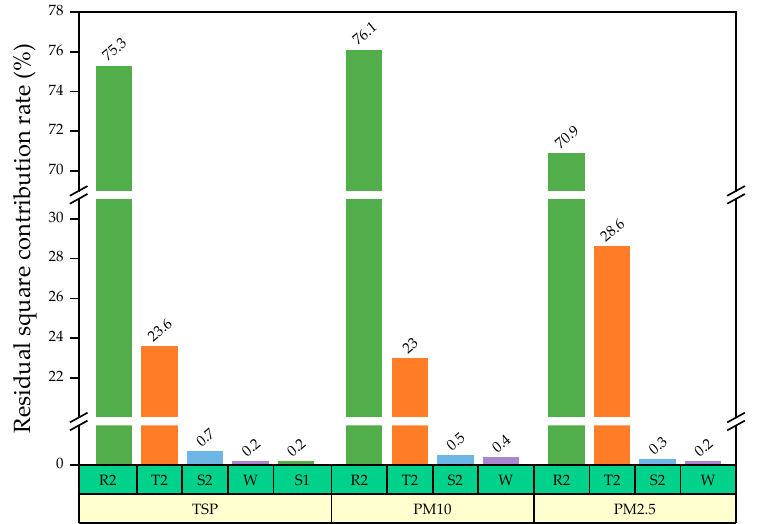
Figure 9. Evaluation of the contribution of meteorological factors to the PM concentration.